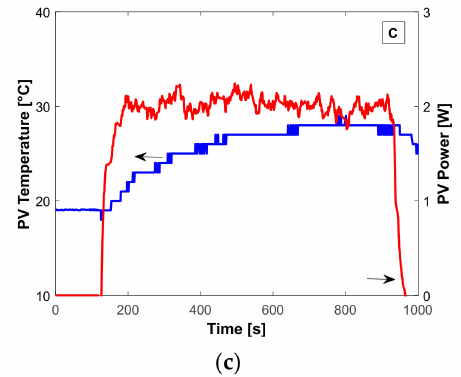
Figure7. MainelectricparametersduringbatterychargingoperationsperformedthroughPVgeneration system: ( a ) battery voltage and current; ( b ) PV voltage and current; ( c ) PV temperature and power.